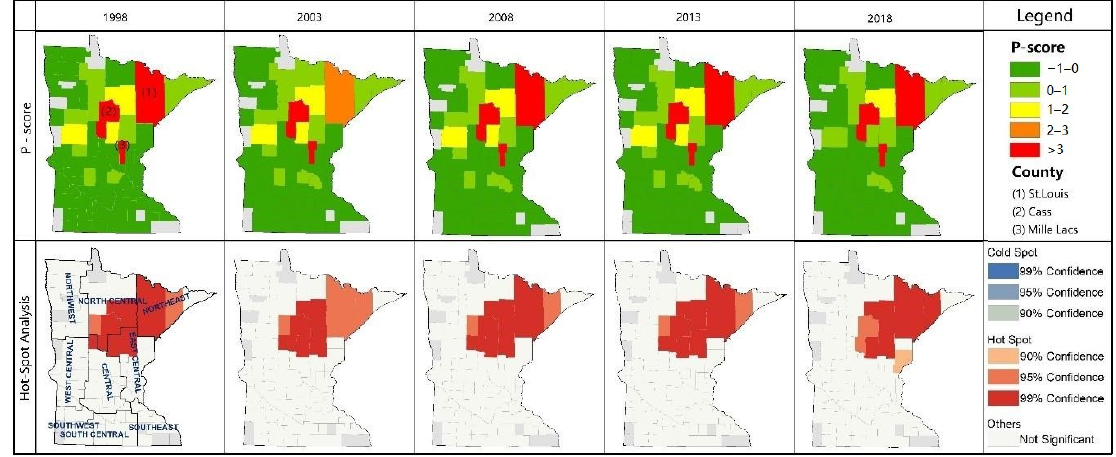
Figure 10. P-score distribution and spatial clustering.